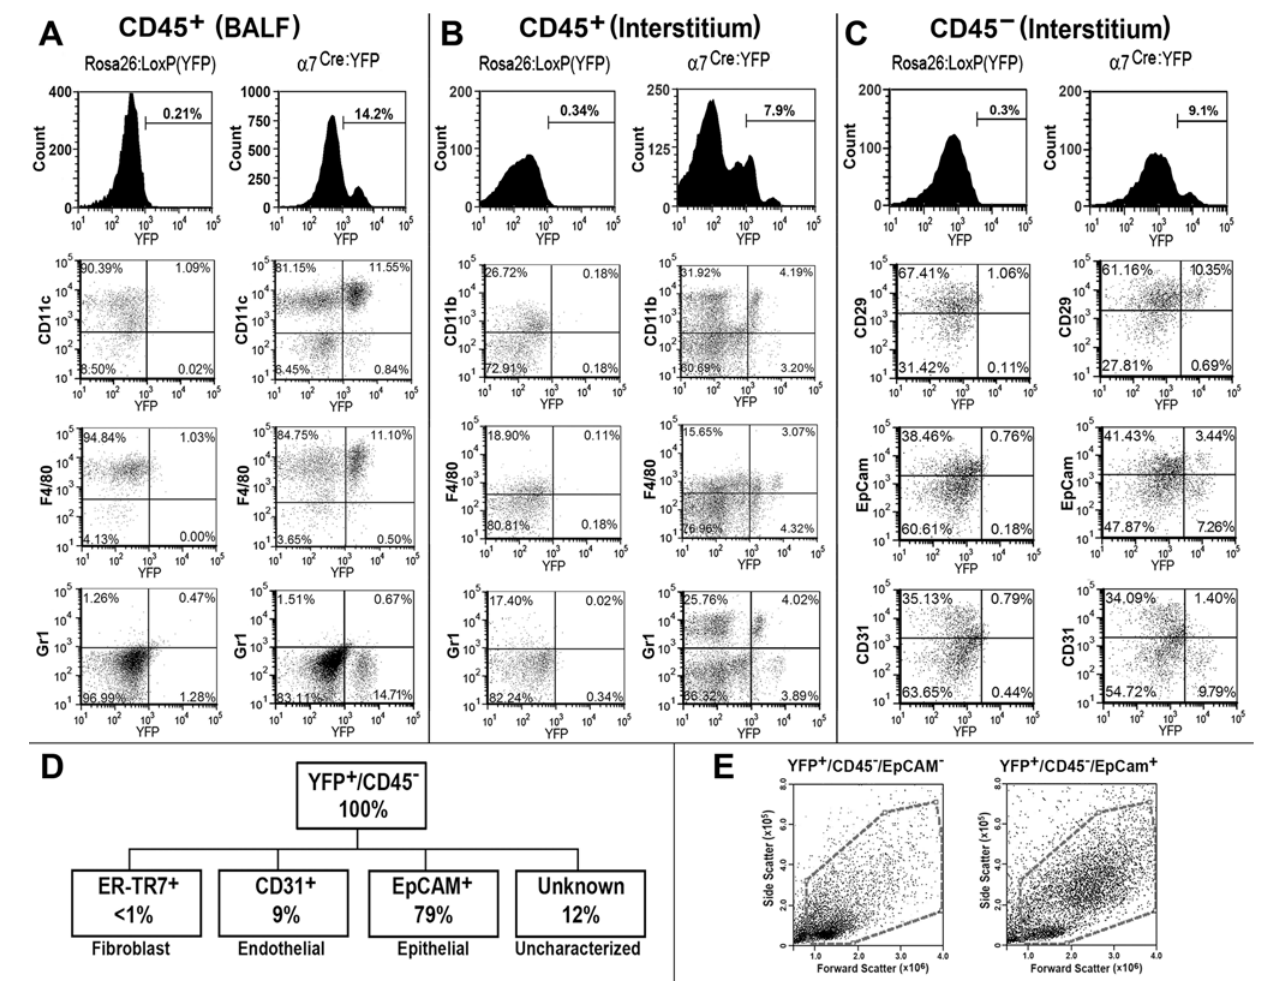
Fig 1. Mouse α 7 lineage-marked lung cells are both CD45 + and CD45 - . BALF cells were collected from groups of 3 – 5 mice (3 – 4 months old) na ï ve ROSA: YFP or α 7 Cre:YFP mice (3 – 4 mo old). BALF cells were pooled from each genotype and then blocked with anti-CD16/CD32 antibodies (FcR γ ) to prevent non- specific binding. Cells were then stained with monoclonal antibodies directed against mouse CD45, CD11c, F480 (F4/80) or Gr1 and analyzed by FACS for these markers as well as YFP expression. (A) A representative experiment shows the percent of total CD45 + cells in the gates as indicated. (B, C) Following removal of BALF, the remaining lung tissue (Interstitium) was digested (see Methods) and the single cell suspensions blocked and stained for to group cells into the hematopoietic (CD45 + ; B) or non-hematopoietic (CD45 - ; C) lineages. Additional markers appropriate to the respective lineage were then used including those specific to CD45 - interstitial cells (CD29, EpCam, and CD31) and again quantitated in terms of α 7 lineage (YFP + or YFP - ). (D) The results of multiple measurements are summarized in in terms of the average percentage of α 7 lineage (YFP + or YFP - ) CD45 + or the CD45 - populations including markers of fibroblasts (ER-TR7), endothelial cells (CD45-, CD31+, EpCAM - ) and epithelial cells (CD45 - , EpCAM + , CD31 - ) cells. The majority of the CD45 - YFP + interstitial cells are EpCAM + that identifies epithelial cells. Some cells (12%) were not identified by the markers examined. The mean of each measurement varies by approximately 5% between experiments. (E) Examination of the forward scatter (indicator of cell size) and side scatter (indicator of granularity) of the YFP + /CD45 - /EpCAM - (left panel) and YFP + /CD45 - /EpCAM + cells establishes the difference in their respective morphology. Stained samples were analyzed by FACS using FCS Express software. In all cases each experiment was repeated at least 3 times with each experimental group consisting of 3 – 5 mice.